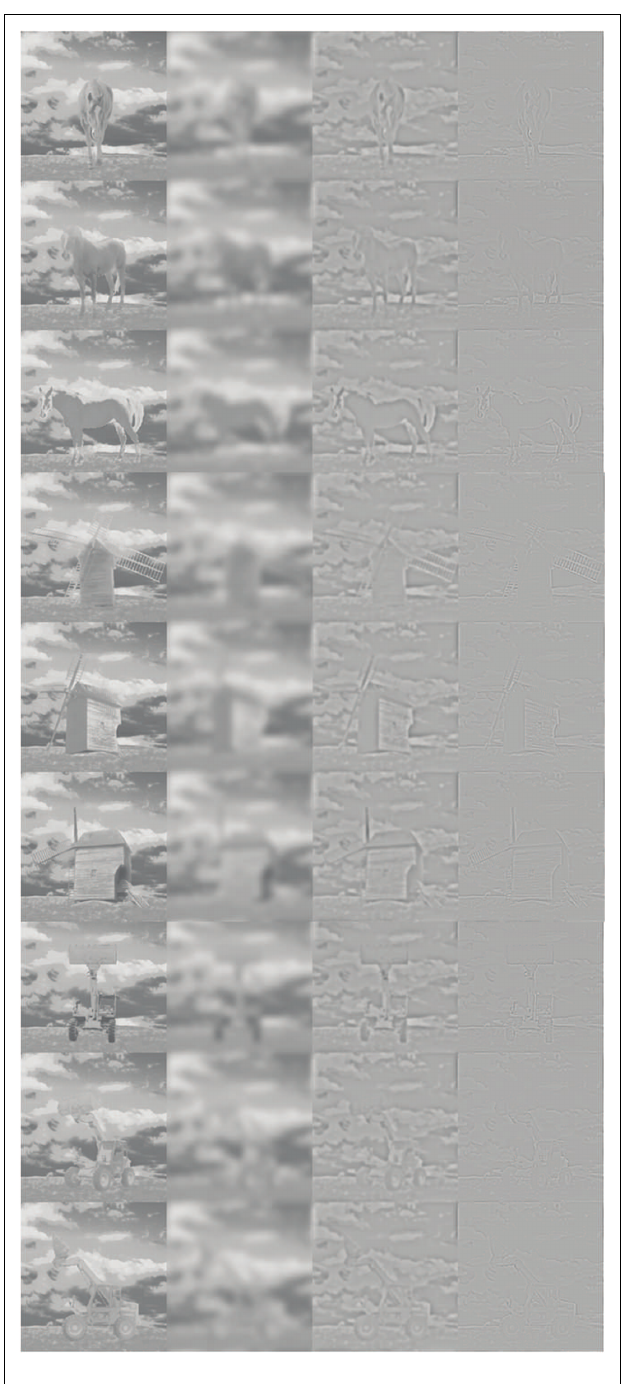
FIGURE 1 | From left to right: respectively FS, LSF, MSF, and HSF stimuli. Top to bottom, the three viewpoints for the horse, the windmill, and the backhoe are